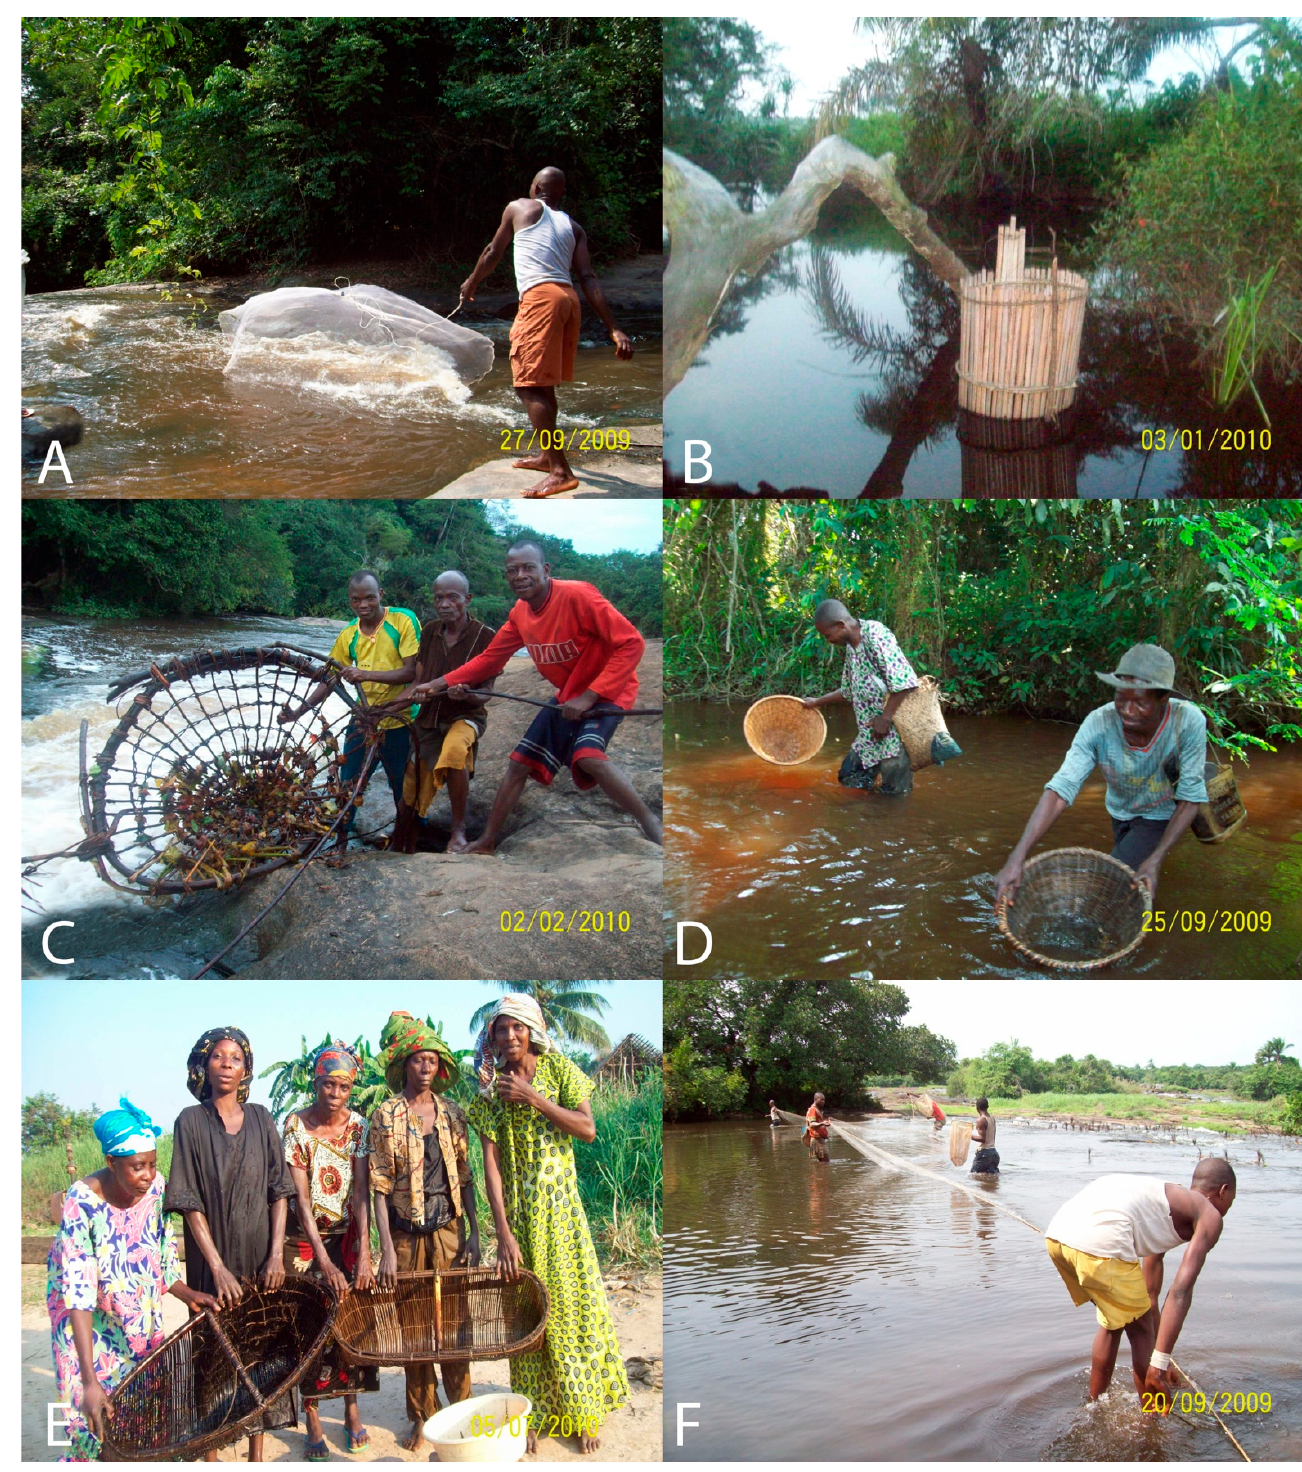
Figure A3. Fishing techniques: ( A ) cast net fishing; ( B ) passive basket fishing (traps) used in lotic habitat; ( C ) passive basket fishing (traps) in rapids and waterfalls; ( D ) active basket fishing in shallow stream; ( E ) active basket fishing in shallow ponds; ( F ) dip and seine net fishing.